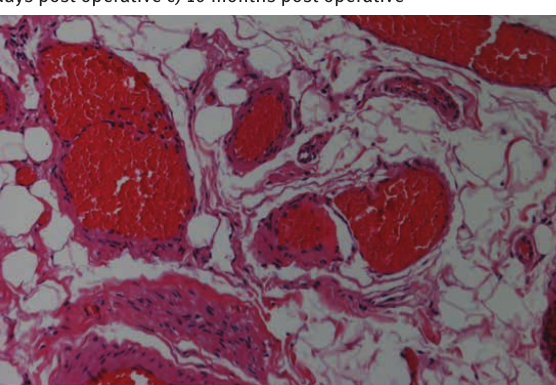
Figure 4: Follow-up at 10 months A) preoperative situation B) 10